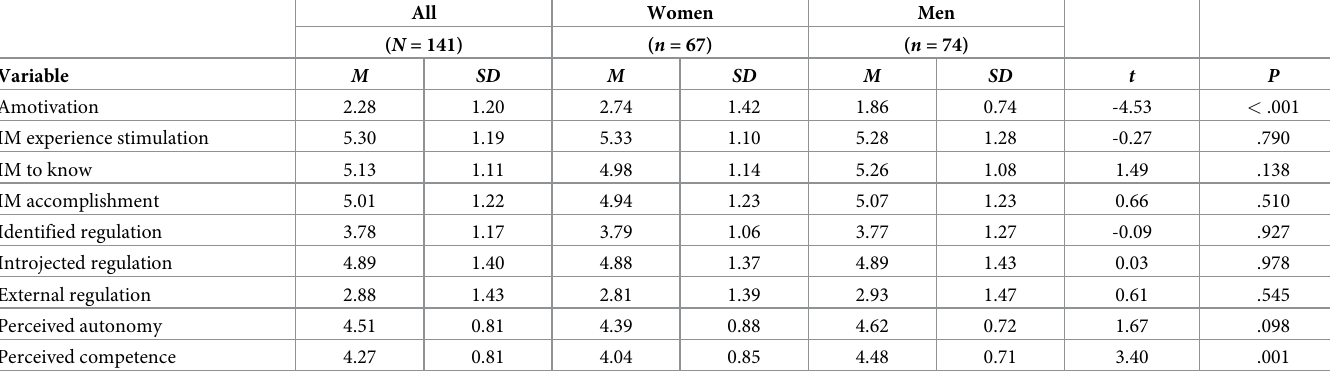
Table 1. Means, standard deviations and gender-differences in conservatoire students’ behavioural regulations, amotivation, and psychological needs satisfaction (autonomy and competence).